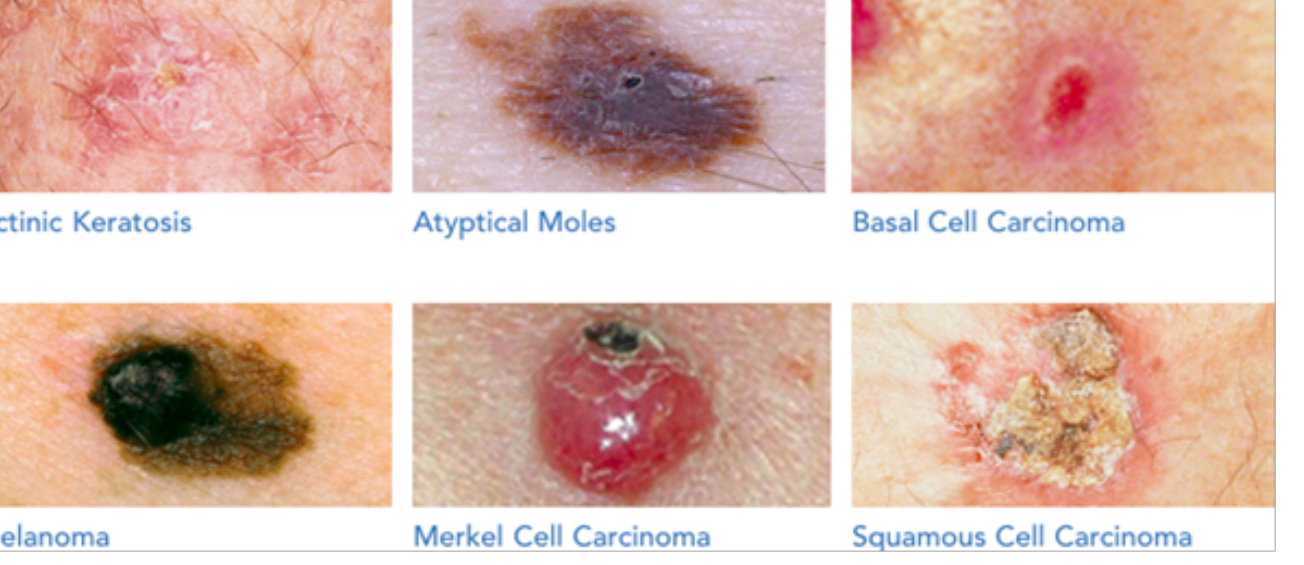
Figure 1. Different kinds of skin cancer classified by the Skin Cancer Foundation [4]. The dominating cause of such skin cancer forms is skin tissue damage caused by UV radiation [5–21]. A dermatologist’s visual examination is a common clinical proce- deceptive [19]. Dermoscopy is a non-invasive diagnostic method that interconnects